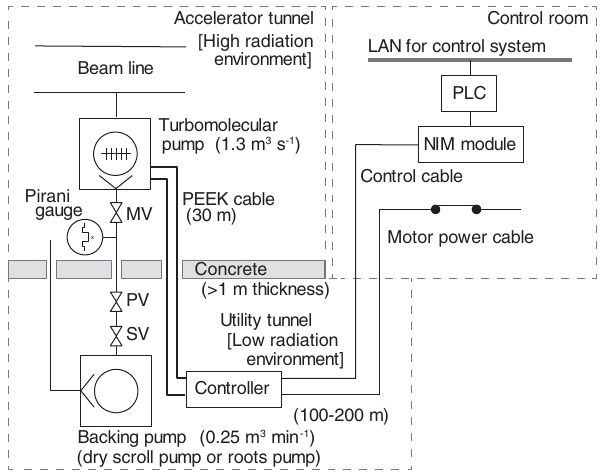
FIG. 3. Configuration of a TMP system. The radiation-resistant TMP is installed in the accelerator tunnel. The TMP controller and the backing pump, which are not radiation resistant, are installed in the utility tunnel. The accelerator tunnel and utility tunnel are separated by the concrete floor with a thickness of more than 1 m. Thus, the radiation is much lower in the utility tunnel compared to the accelerator tunnel. There are three types of valves between the TMP and the backing pump, which are metal manual valve (MV), pneumatic valve (PV), and solenoid valve (SV). The SV closes when the electrical voltage is not applied to the backing pump.